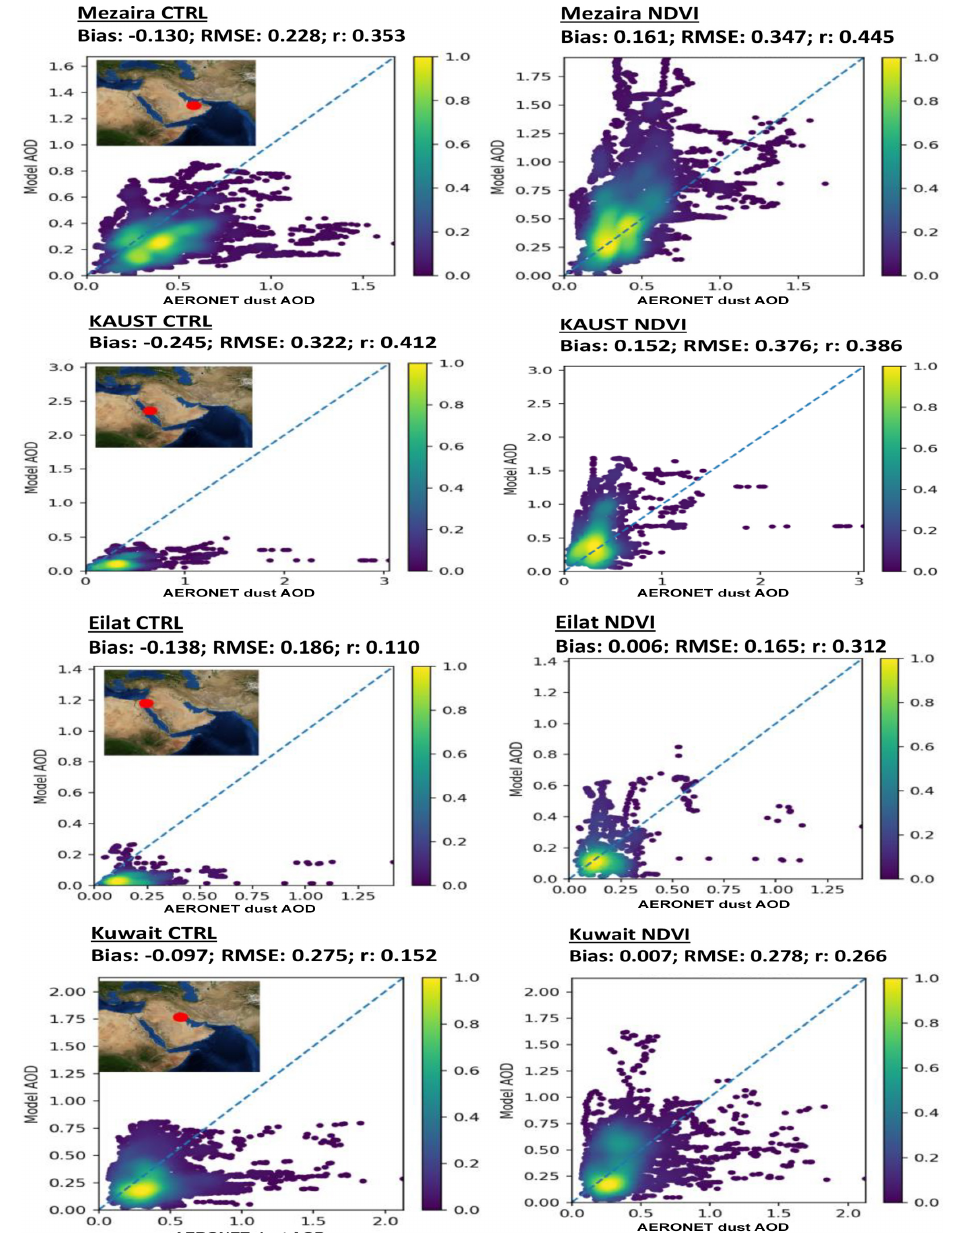
Figure 5. Density scatterplots of modeled and AERONET dust AOD at the stations of Mezaira, KAUST, Eilat, and Kuwait for 2016.